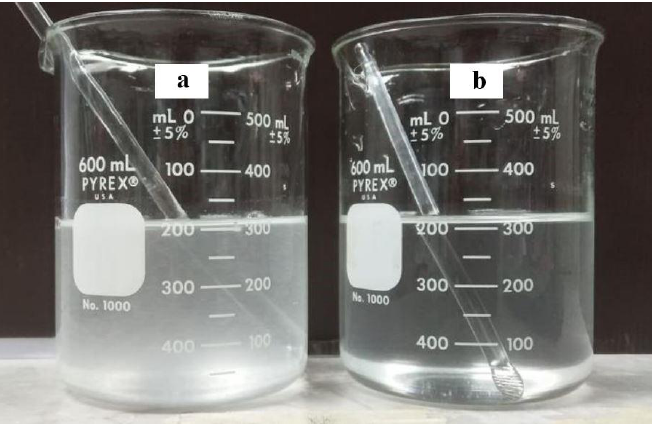
Figure 4. Appearance of the mixtures prepared using the 150-mg -fluconazole capsule ( a ) and F5 tablet ( b ) in 300 mL of distilled water.